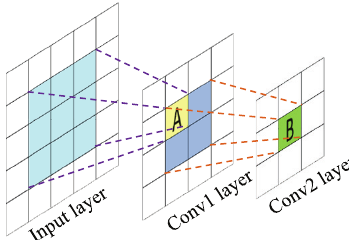
Figure 5. A simple illustration for receptive field of different layers. The receptive fields corresponding to location “A” and “B” are 9 and 36,